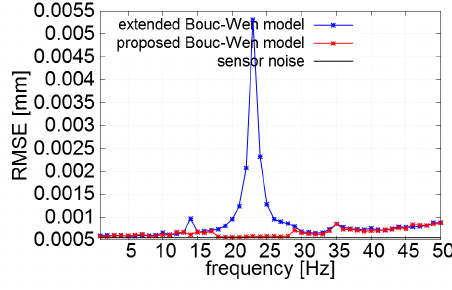
Figure 10. The RMS modeling errors as a function of the input frequency.